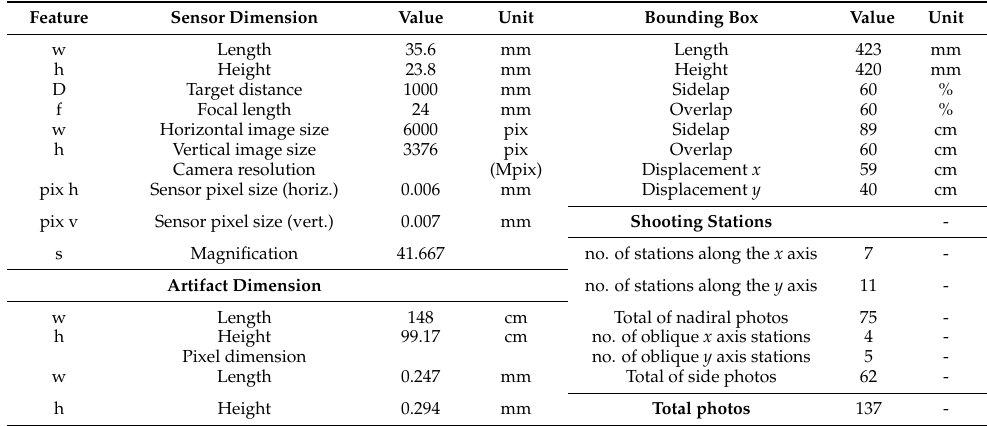
Table A1. Technical performance of the camera model SONY